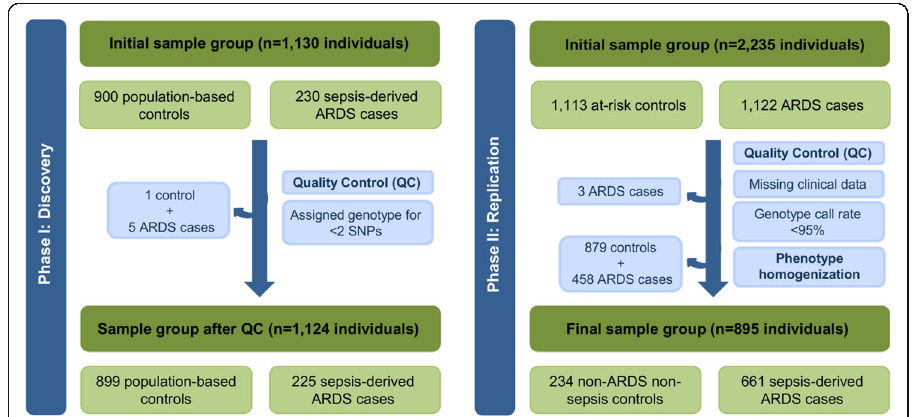
Fig. 2 Workflow of the study design. Quality control steps performed in each stage for the samples